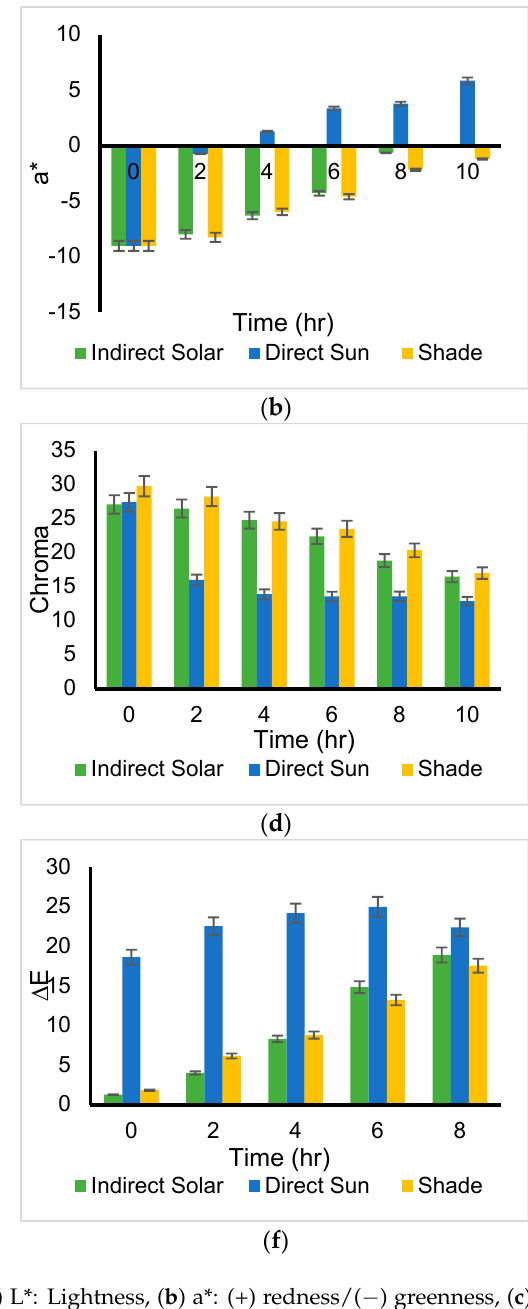
Figure 10. Mint color parameters: (( a ) L*: Lightness, ( b ) a*: (+) redness/( − ) greenness, ( c ) b*: (+) yellowness/( − )blueness, ( d ) Chroma, ( e ) Hue, and ( f ) color difference) degradation during indirect solar-drying ( n = 3).